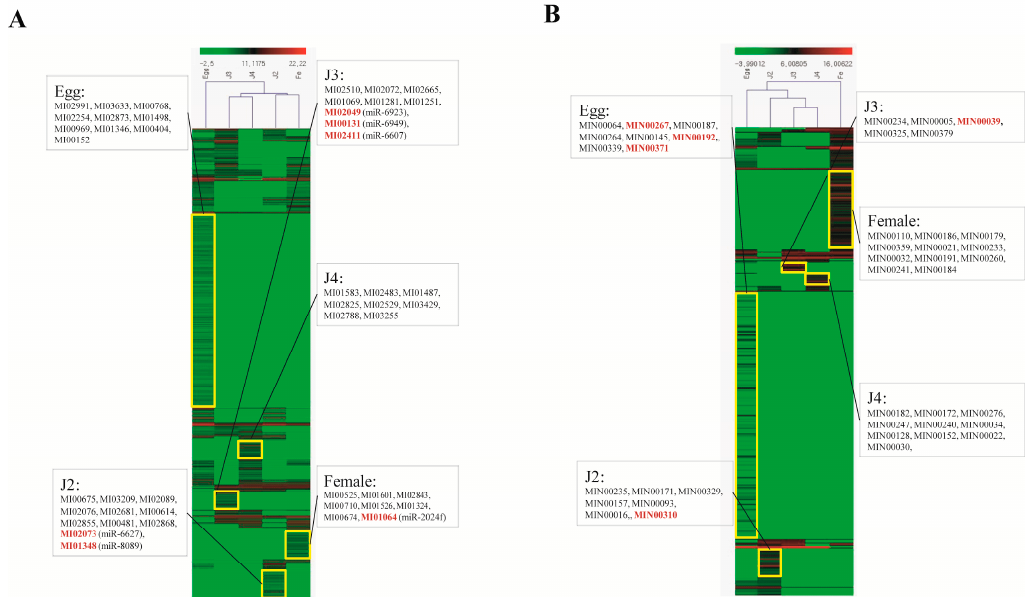
Figure 7. Heat map for the DESeq2-normalized expression profiles of known and novel miRNA families in five developmental stages. ( A ) Known miRNA; ( B ) novel miRNA. In both cases, sequences with R > 10 were selected for normalization. The heatmap of the normalized data (Tables S11 and S12) was drawn using MeV (v4.8.1) Pearson correlation applied for clustering. The TreeView tool was used to improve the figure clarity.